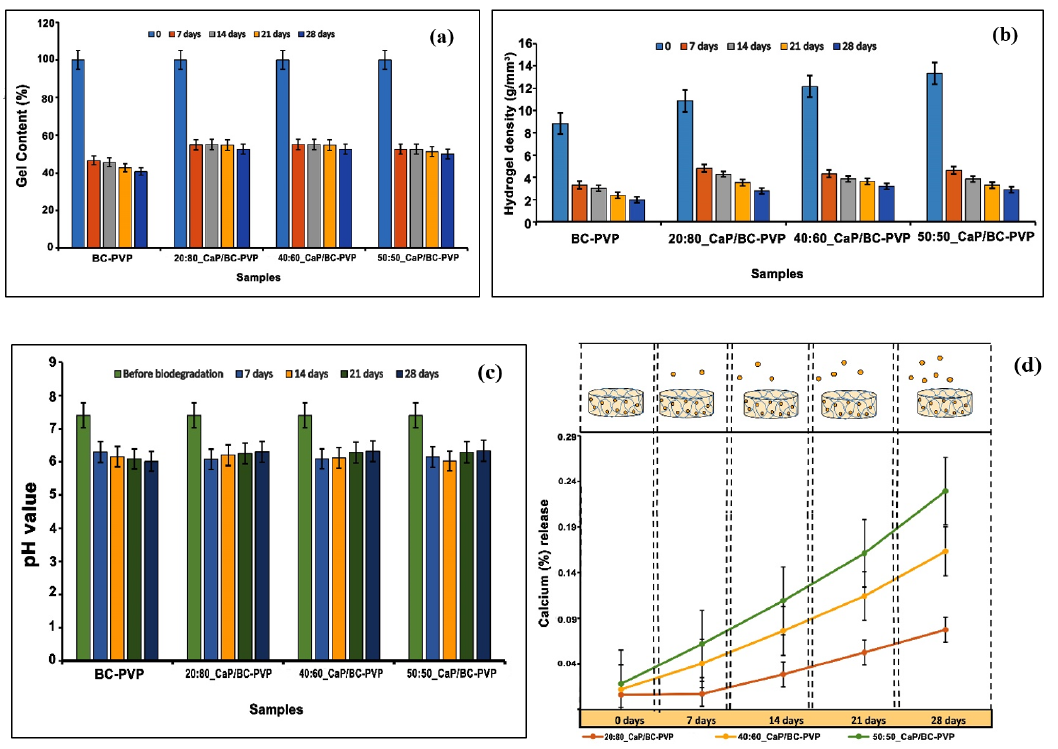
Figure 4. Gel content (%) histogram ( a ) and ( b ) Hydrogel density profile before and after 7, 14, 21, and 28 days of hydrolytic degradation analysis; pH change ( c ) and calcium release (%) profile ( d ) in the medium after 7, 14, 21, and 28 days of hydrolysis degradation analysis of calcium phosphate incorporated BC based hydrogel scaffolds (i.e. BC-PVP, 20:80_CaP/BC-PVP, 40:60_CaP/BC-PVP, and 50:50_CaP/BC-PVP).